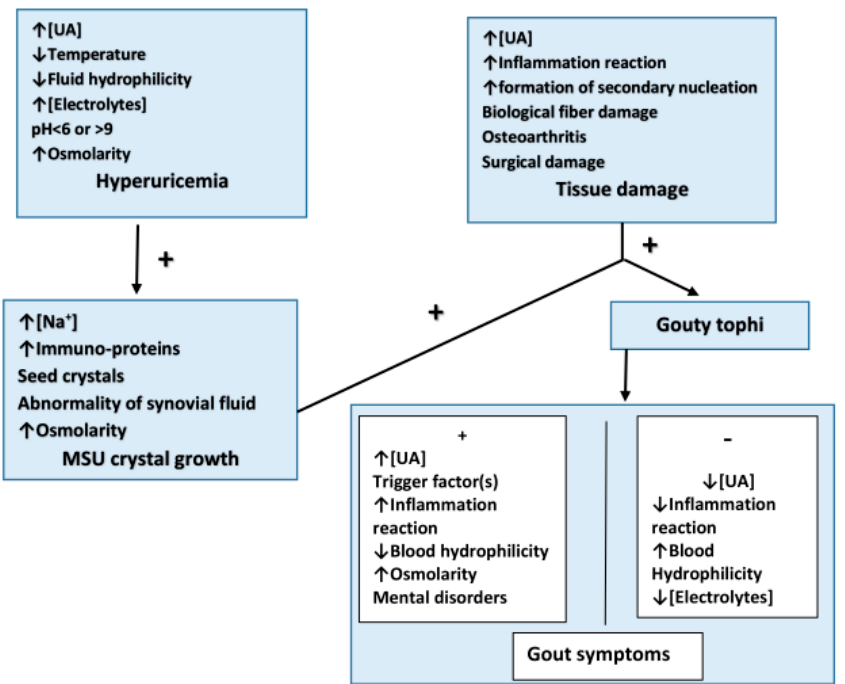
Figure 2. A summary of the prerequisite from hyperuricemia to gout flare. UA is involved in the pathogenesis of hyperuricemia and gout formation. Hyperuricemia could only be accompanied by the aforementioned factor(s) to instigate a gout flare. + Favorable; − Adverse; UA: uric acid. Funding: This research received no external funding. Key taking home messages: 1. The role of serum uric acid (SUA) should, above and beyond, be an exclusive indicator of a gout flare. 2. Hyperuricemia would not be the only Conflicts of Interest: The authors declare no conflict of interest. risk factor of a gout flare due to many irrelevant elements between them. 3.